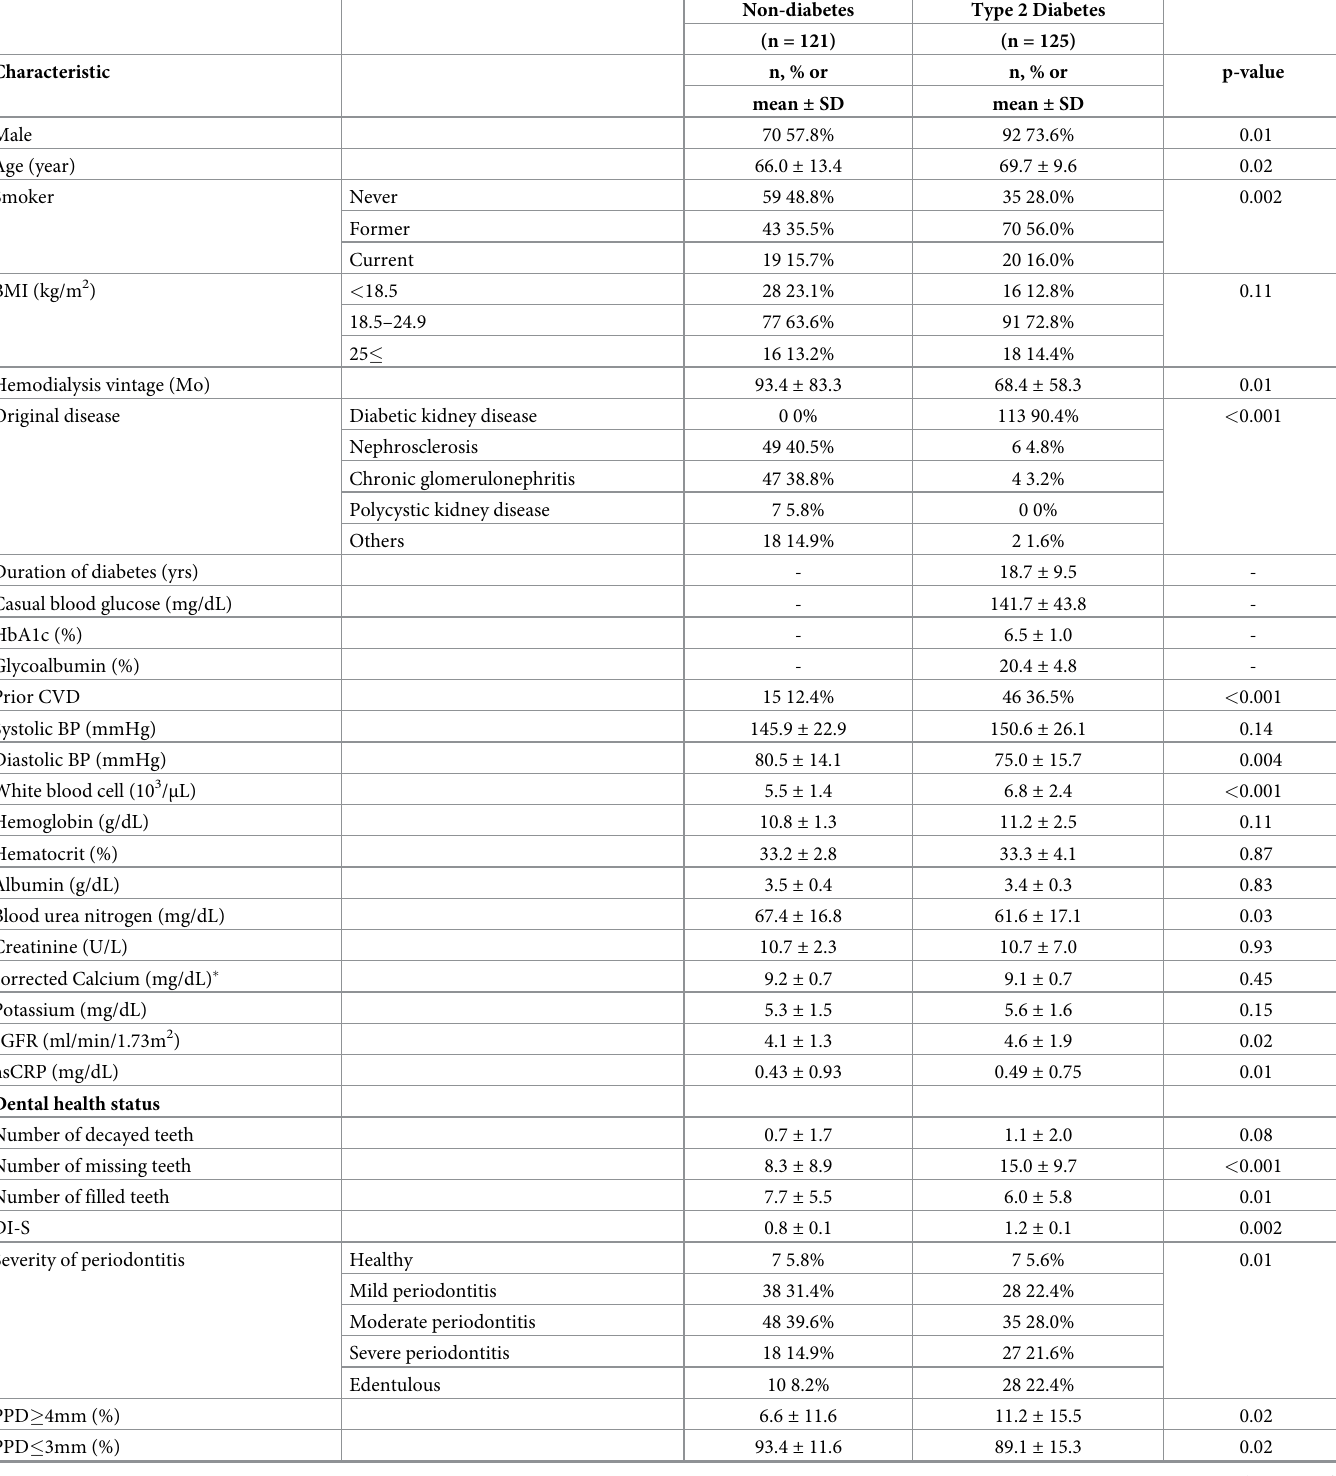
Table 1. Characteristics of the study